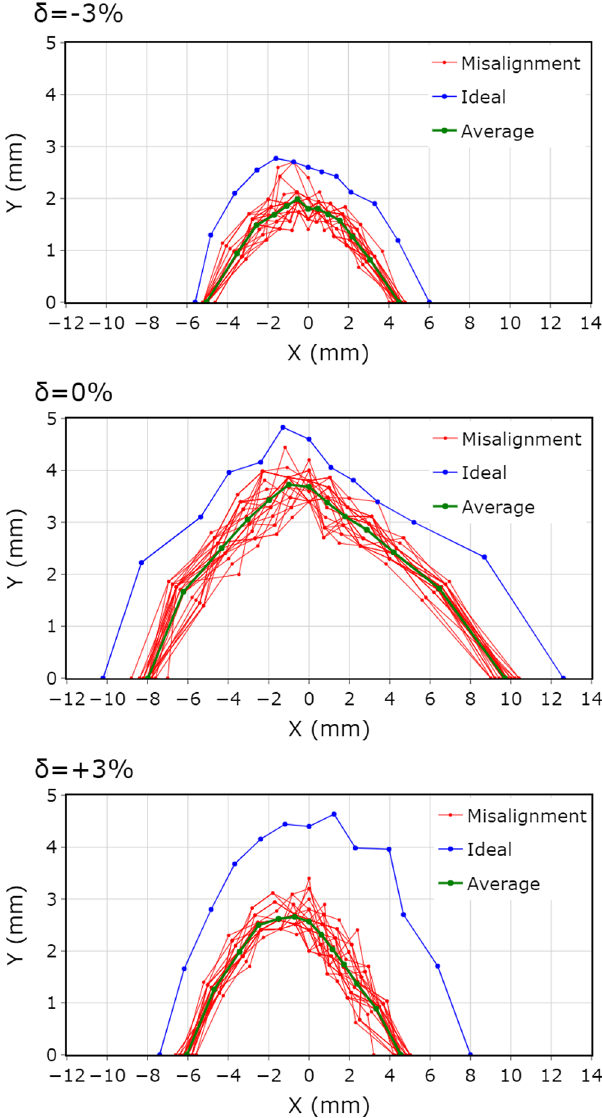
FIG. 22. Transverse dynamic aperture (rf ON) with corrected alignment errors (24 samples) for δ ¼ − 3% (top), δ ¼ 0% (middle), and δ ¼ þ 3% (bottom).